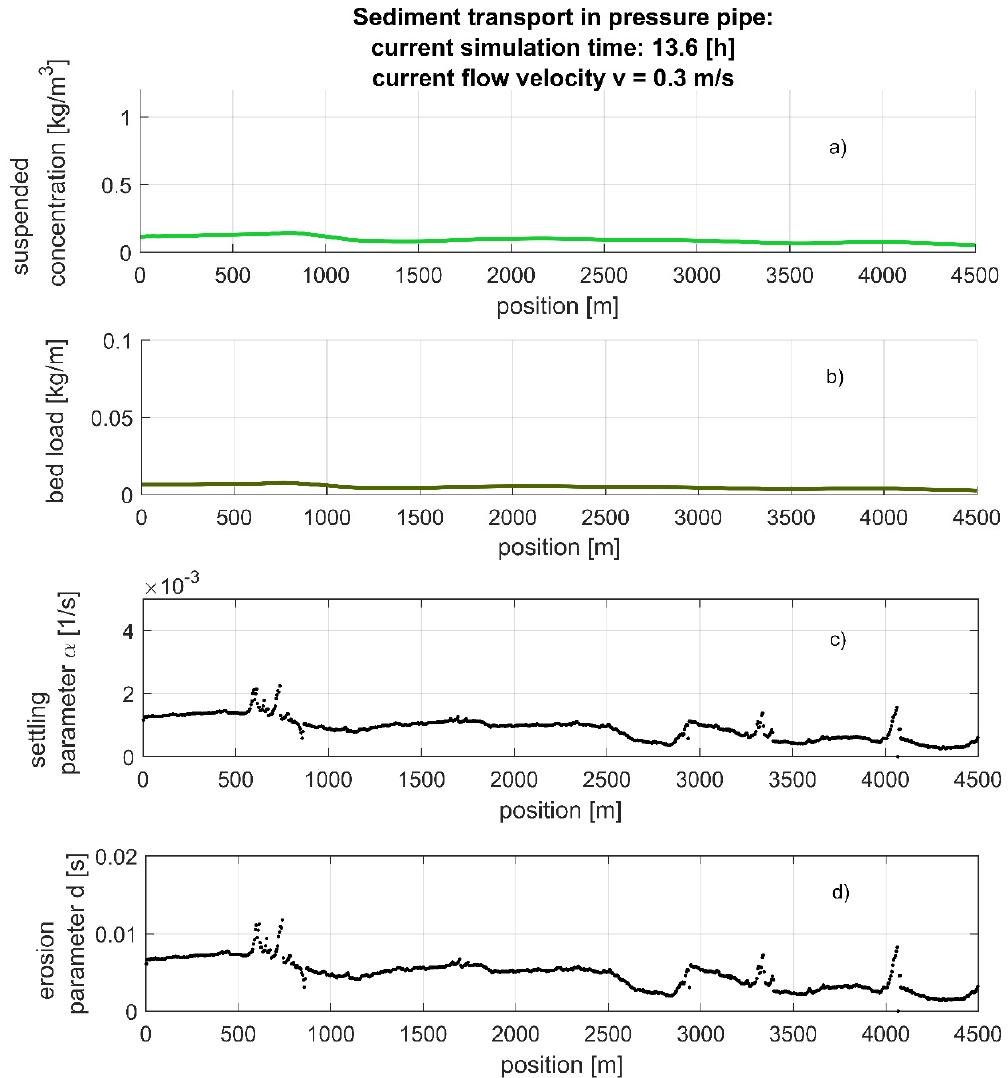
Figure 2. Status panel of the sediment transport simulation. ( a ) present suspended load inside the pressure pipe at each grid position. ( b ) present bed load inside the pressure pipe at each grid position. ( c ) present settling parameter α inside the pressure pipe at each grid position. ( d ) present erosion parameter d inside the pressure pipe at each grid position.